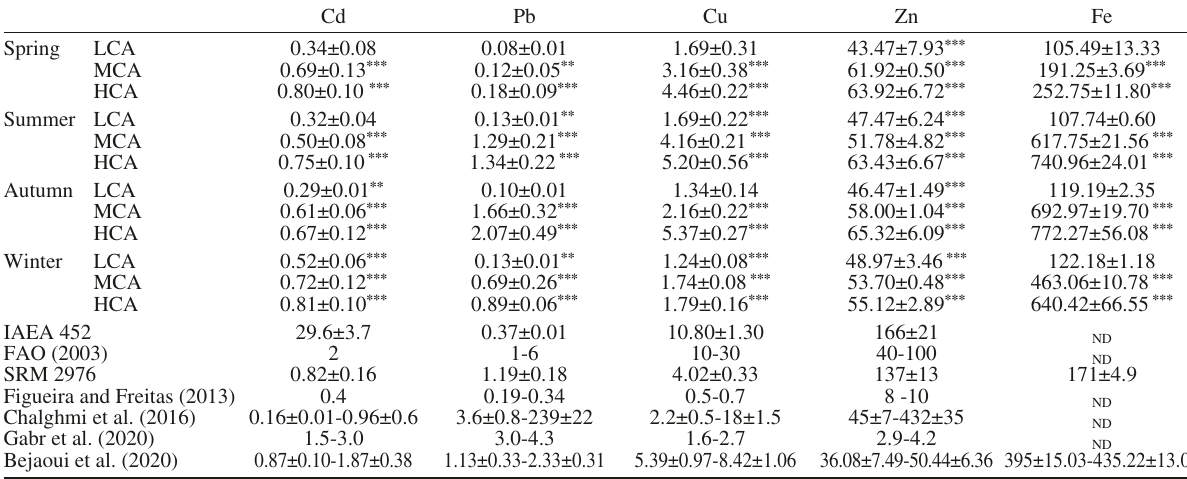
Table 1. – Comparison of trace element concentrations (in mg kg –1 of dry weight) in R. decussatus from Tunisian coasts with other bivalves from different Mediterranean coastal areas. Concentrations are also compared with maximum levels of TE admissible in shellfish flesh, as set by international organizations. LCA, Ghar el Melh; MCA, North Lake; HCA, South Lake. Values are presented as mean±SD (n=6 repetitions). Significant differences are determined at 0.05 using two-way ANOVA: *p<0.05, **p<0.01; ***p<0.001. Metal determination in shellfish